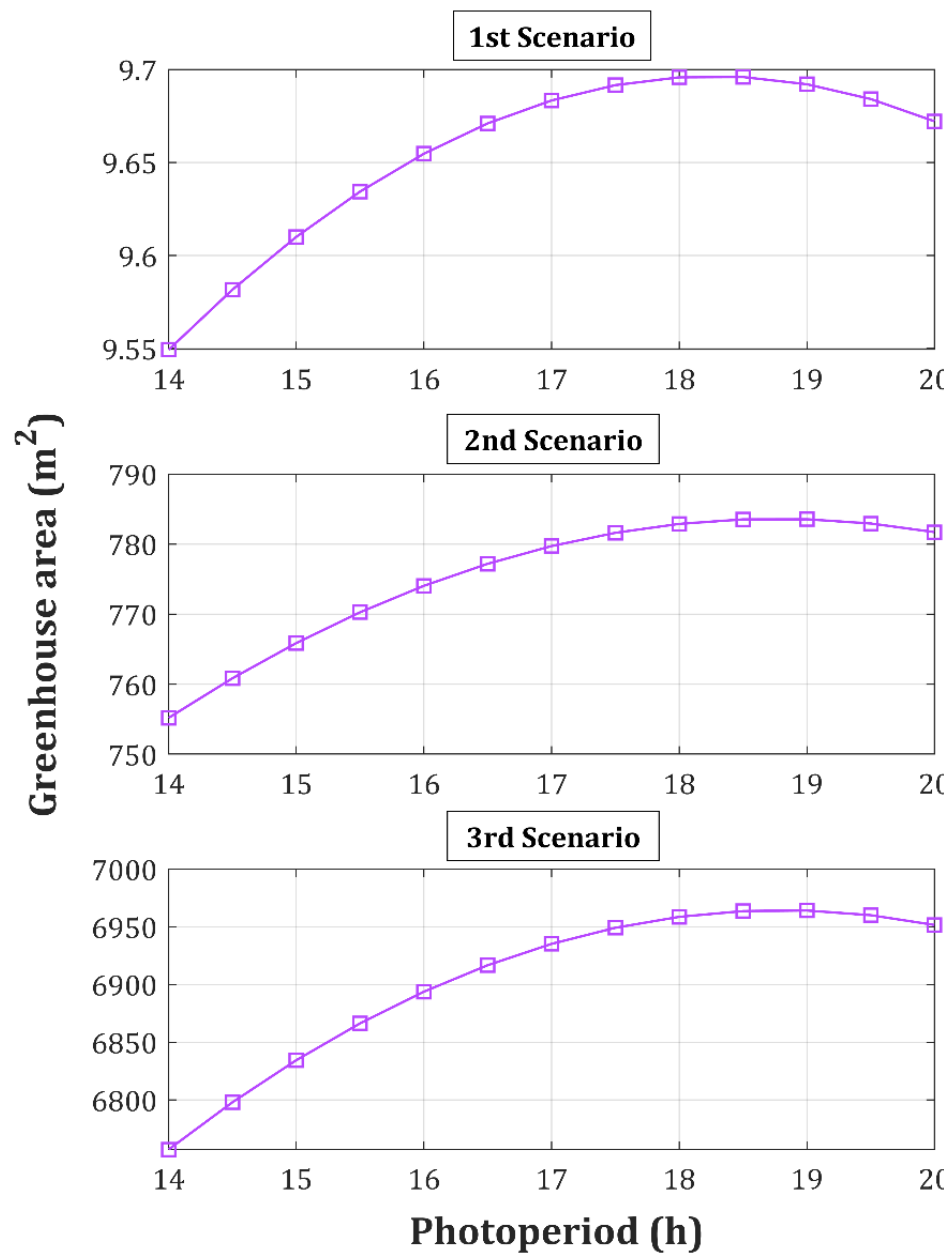
Figure 17. Variations in the greenhouse sizes under the variation in the photoperiod.